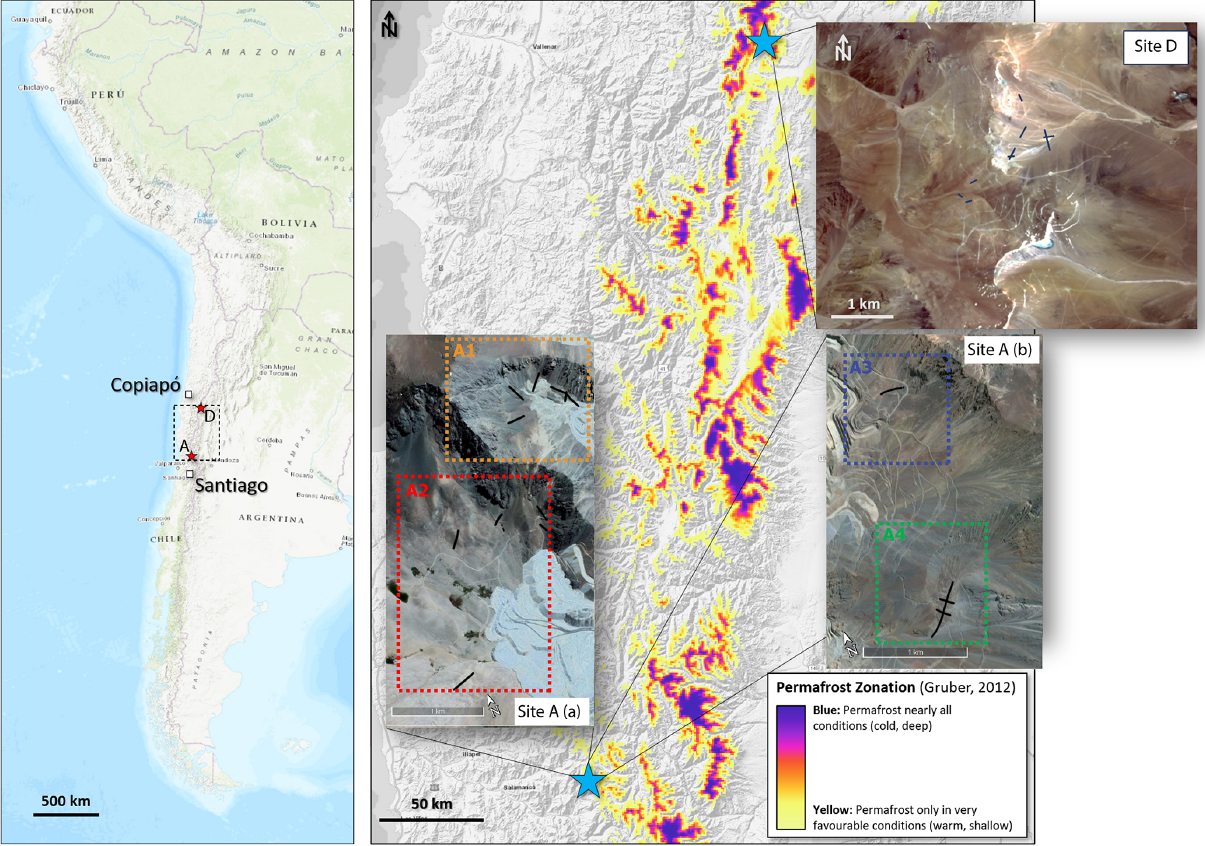
Figure 1. Overview maps of study sites A (rock-glacier-dominated site, including various sub-study areas A1–A4) and D (rock-glacier-free site) in the Central Andes of Chile and Argentina. The permafrost zonation index following Gruber (2012) shows the modeled permafrost distribution within the Central Andes. Black lines indicate the position of the geophysical profiles. Map data: Site A: Google, © 2022, Maxar Technologies; Site D: DigitalGlobe, accessed in Global Mapper V22 (Blue Marble Geographics), date